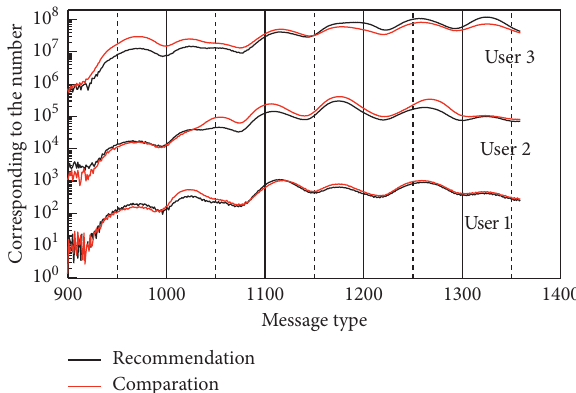
Figure 6: Relationship between matching accuracy and input information.